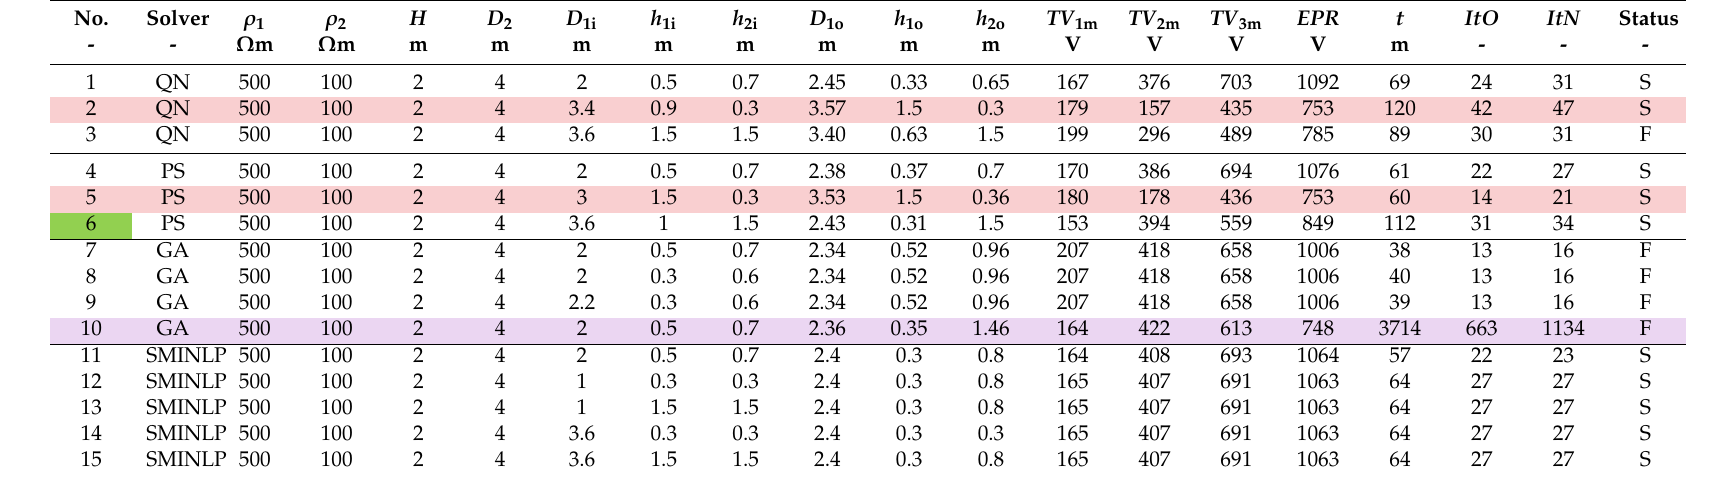
Table 6. Part 1. Ansys Maxwell optimisation analysis results. Part 2. Ansys Maxwell optimisation analysis results. Part